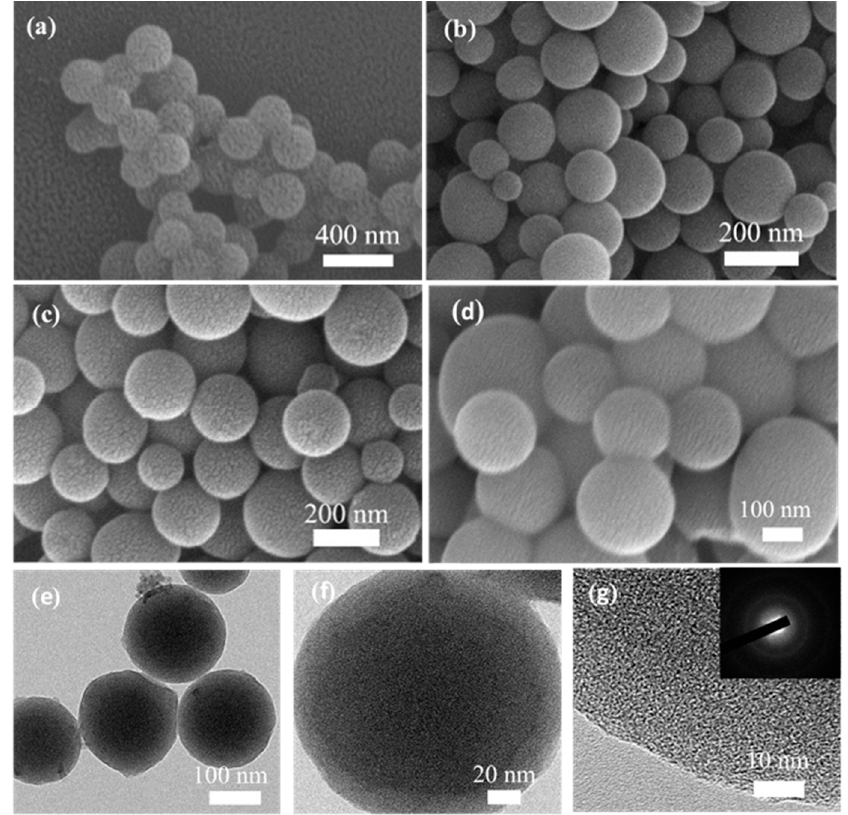
Figure 2. SEM images of ( a ) HSs, ( b ) ACSs, ( c ) ACSs-N, and ( d ) NCSs. TEM images of ( e ) low magnification, ( f ) high magnification, and ( g ) high-resolution (HR)-TEM for ACSs-N. The inset in Figure 2g is the selected-area electron diffraction (SAED) pattern.